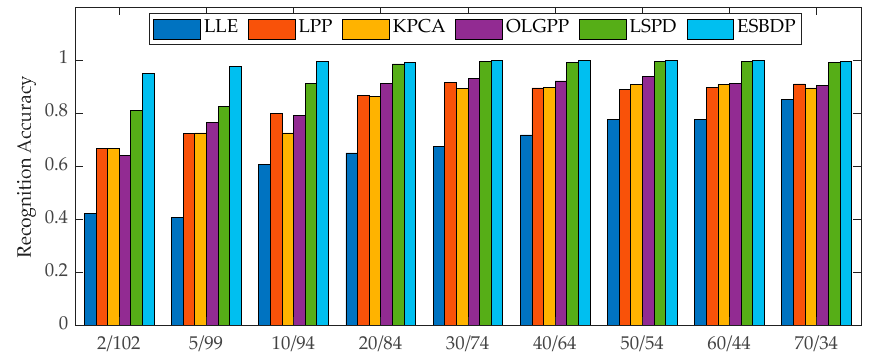
Figure 16. Recognition accuracy under sample variation.